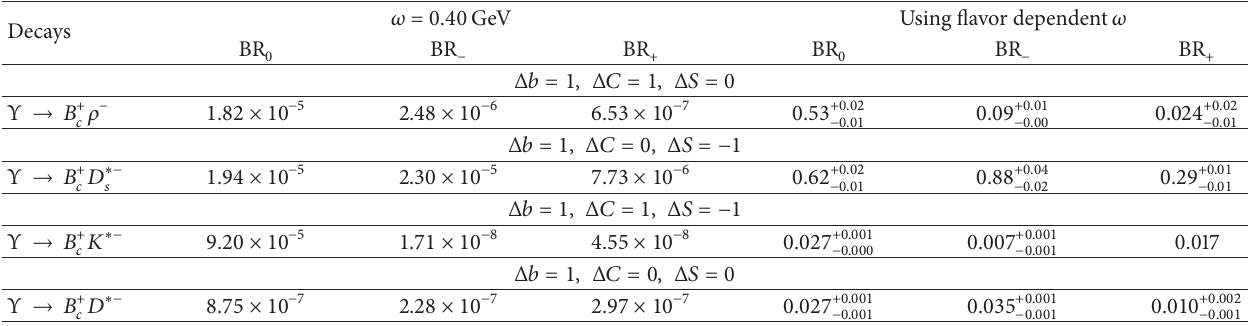
Table 13: Branching ratios BR 0 , BR − , and BR + corresponding to the Helicity amplitudes 𝐻 0 and 𝐻 ±1 (in the units of 10 −10 ) of Υ → 𝐵 𝑐 𝑉